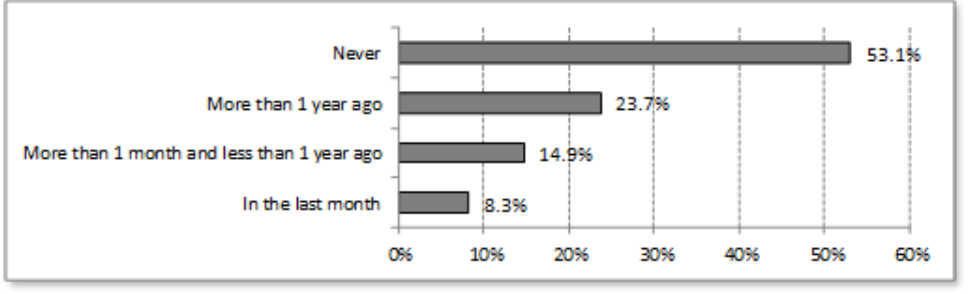
Figure 4. Respondents' last participation in an on-line course (relative data).